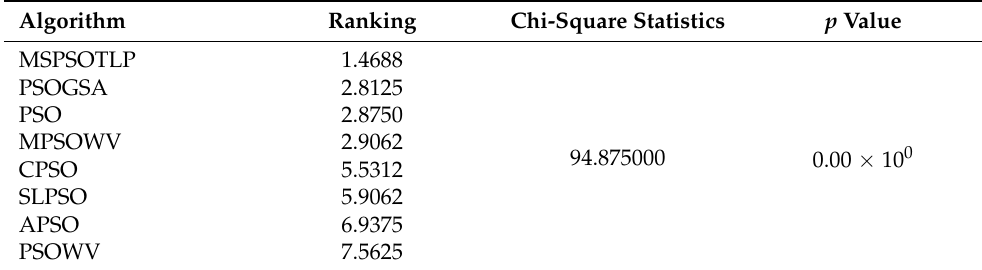
Table 15. The average ranking values of ANN models are trained by all compared algorithms in solving training samples.